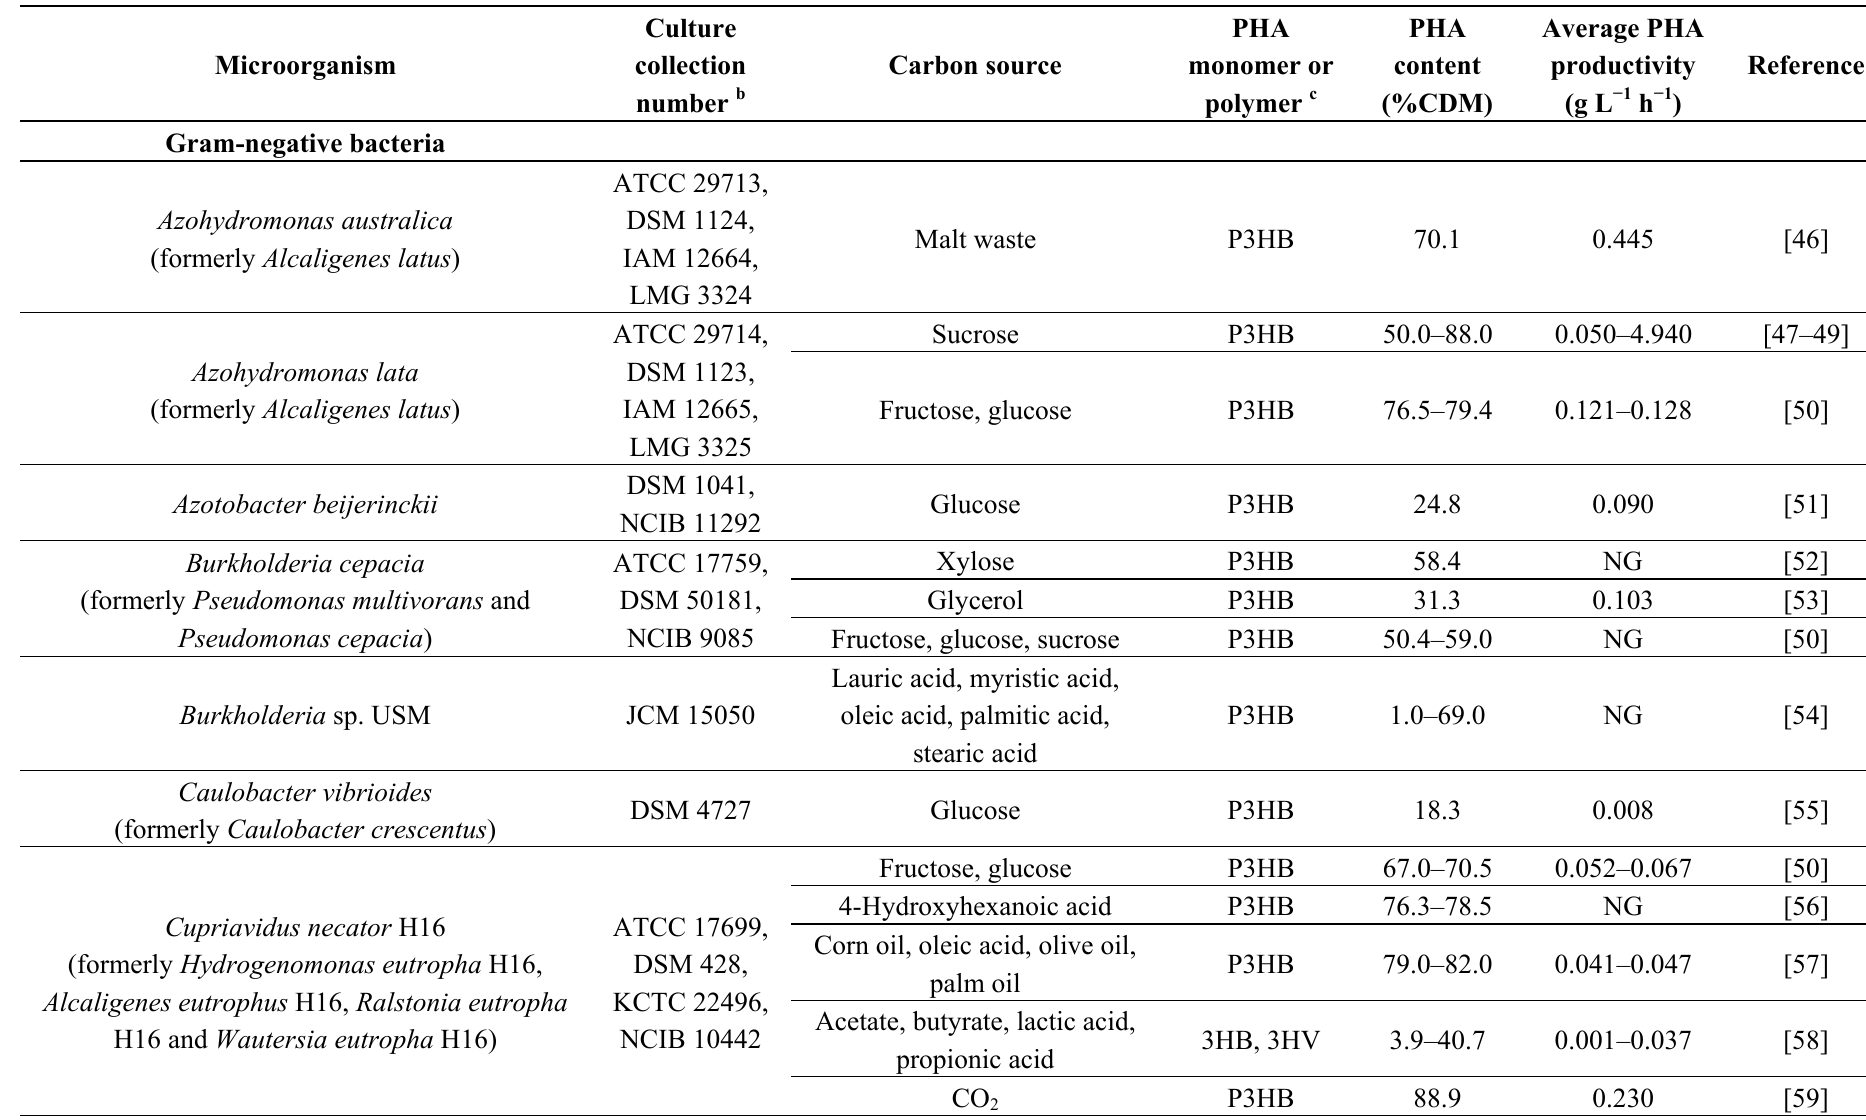
Table 2. PHA-producing microbial strains available in culture